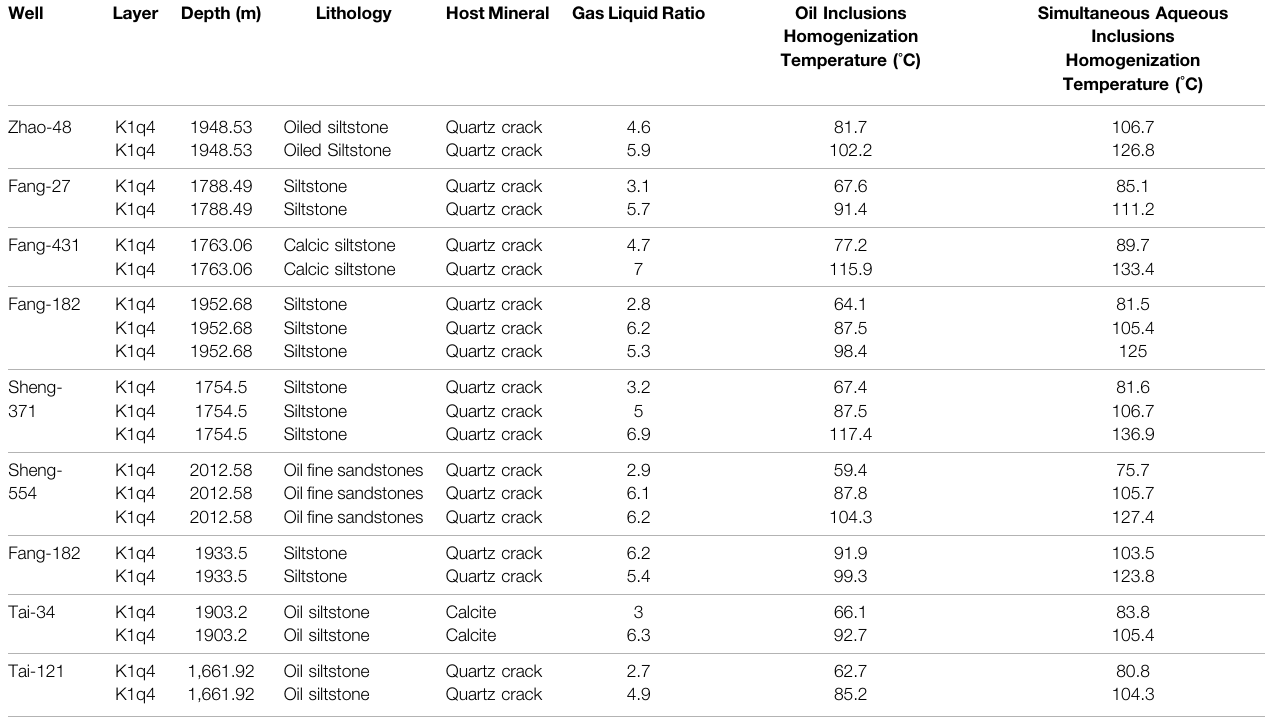
TABLE 1 | Gas-to-liquid ratio of oil inclusion by CLSM.